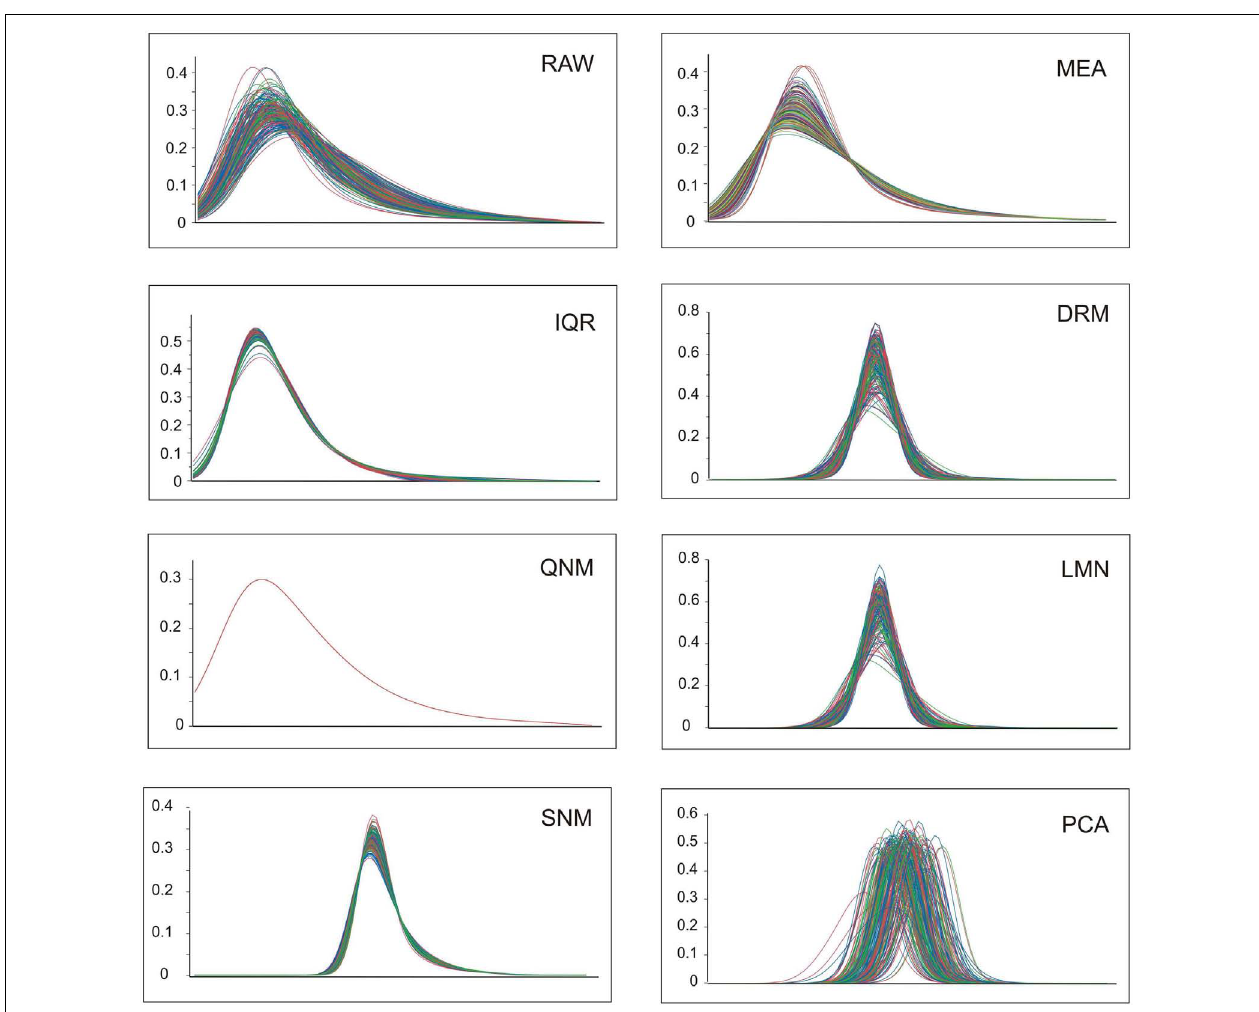
FIGURE 1 | Profile distributions after nine modes of normalization. Each plot shows the frequency distribution of transcripts at increasing levels of expression along the x -axis (the units are removed, since these are not comparable between methods). Colors represent normal weight (blue), heavy (green), or obese (red)